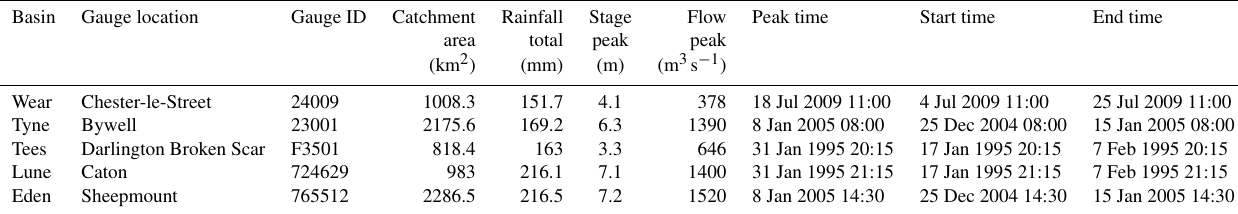
Table 2. Start times are 2 weeks before the observed stage peak times and end times are 2 weeks after the observed stage peak times. This is to allow for model spin-up and inclusion of hydrograph. Rainfall totals are the mean rainfall between the start and end times across the gauged catchment from